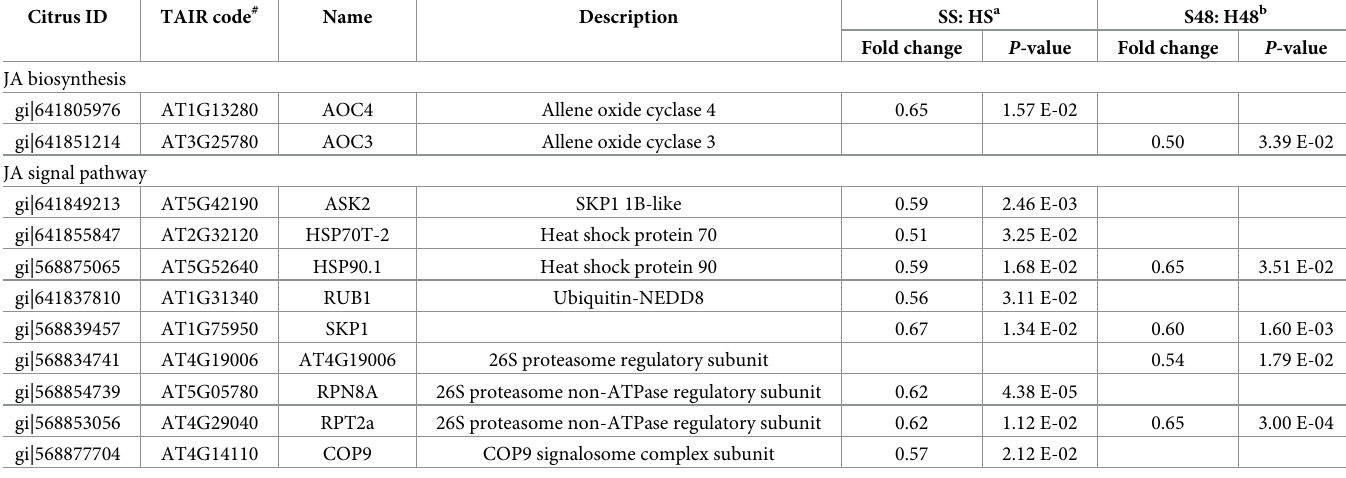
Table 2. Down-regulated fruit proteins involved in the jasmonate (JA) biosynthesis and signal pathway, in response to Huanglongbing (HLB). Citrus